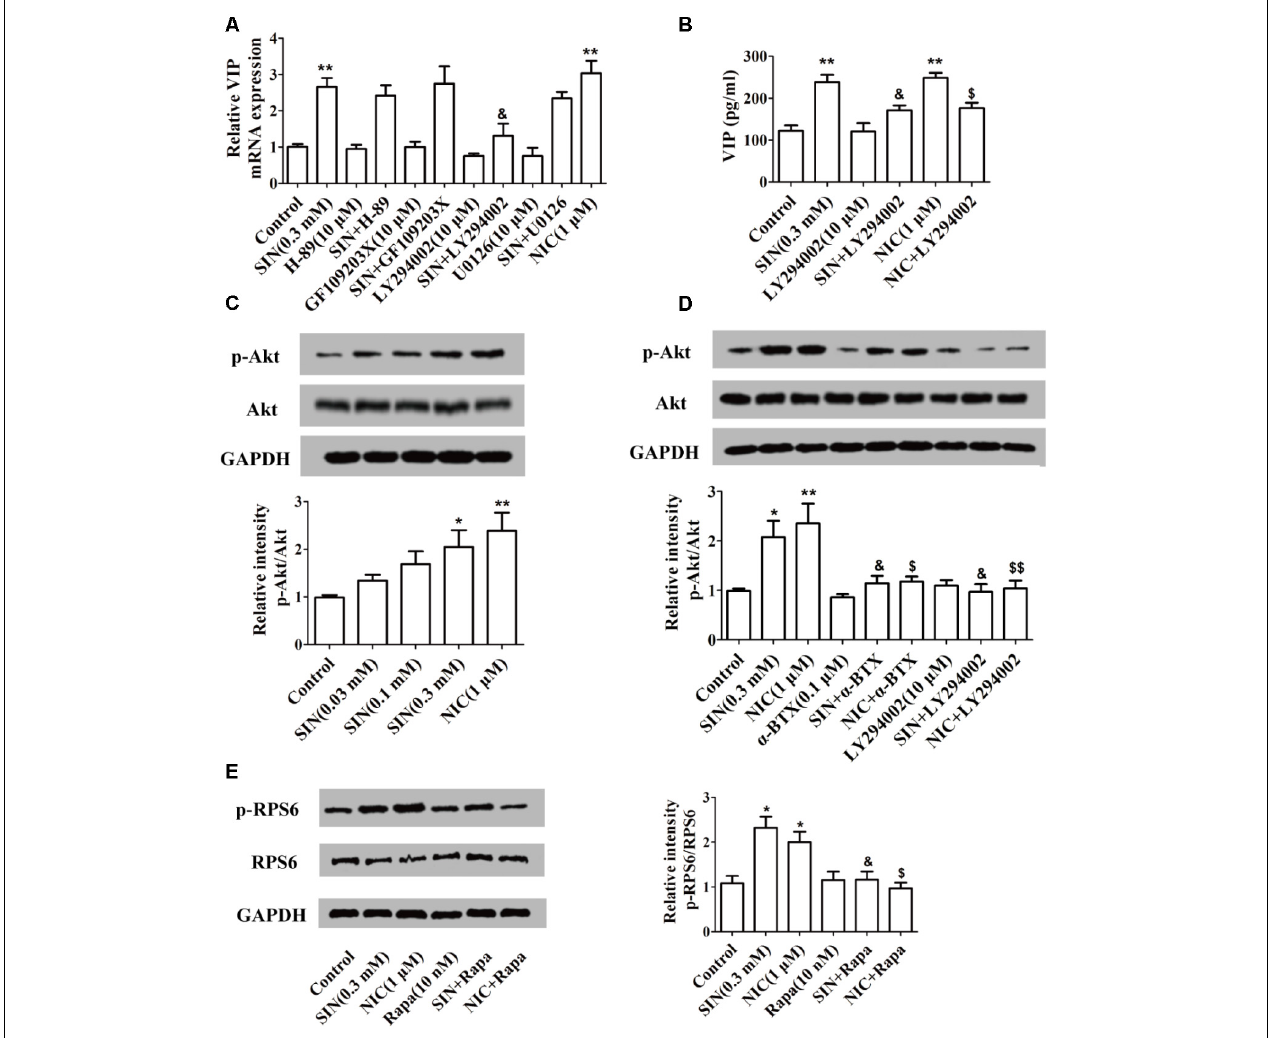
FIGURE 6 | Involvement of α 7nAChR and PI3K/Akt/mTOR pathway in the sinomenine (SIN)-induced VIP expression in PC-12 cells. (A,B) Cells were pre-treated with H-89, GF109203X, LY-294002 or U0126 (10 µ M). After 30 min, cells were exposed to vehicle, nicotine (NIC) or SIN for 24 h. The mRNA and protein level of VIP were measured by quantitative PCR assay and ELISA respectively. (C) The expression of Akt and p-Akt were detected by western blot. (D) Cells were pre-treated with LY-294002 or α -bungarotoxin ( α -BTX, 0.1 µ M). After 30 min, they were exposed to vehicle, NIC (1 µ M) or SIN (0.3 mM) for 24 h. The expression of Akt and p-Akt were detected by western blot. (E) Cells were pre-treated with rapamycin (Rapa, 10 nm). After 30 min, they were exposed to vehicle, NIC (1 µ M) or SIN (0.3 mM) for 24 h. The expression of RPS6 and p-RPS6 were detected by western blot. Data were expressed as means ± SEM of three independent experiments. ∗ P < 0.05 and ∗∗ P < 0.01 versus Control; $ P < 0.05 and $$ P < 0.01 versus NIC; & P < 0.05 versus